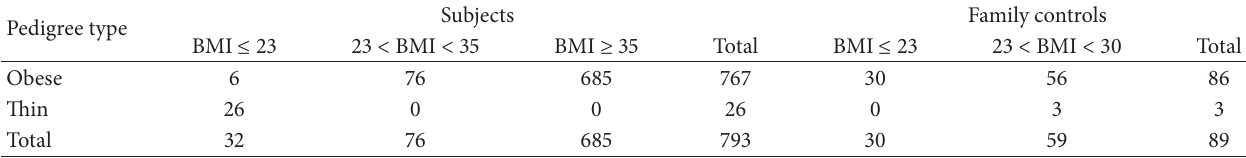
Table 1: Counts of subjects and family controls in the aCGH sample by pedigree type and BMI range. Pedigree type